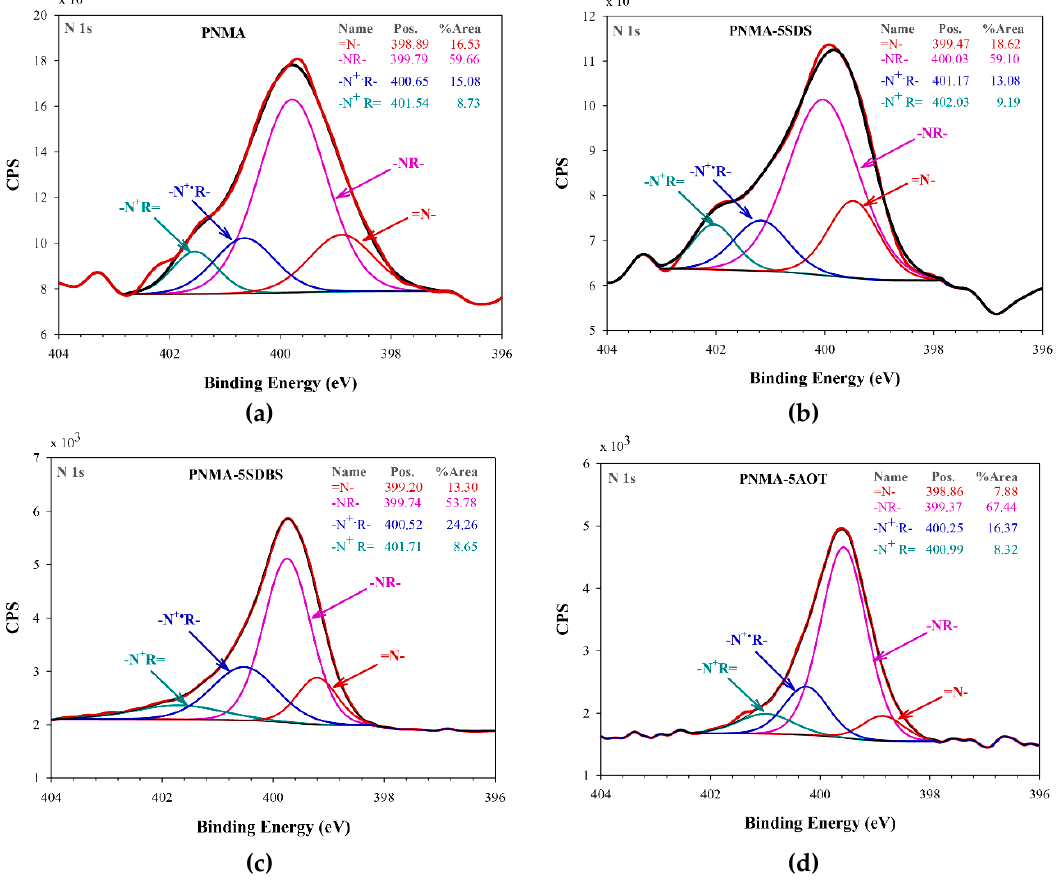
Figure 2. High-resolution N 1s curve fitting of: ( a ) PNMA; ( b ) PNMA-5SDS; ( c ) PNMA-5SDBS; and ( d ) PNMA-5AOT.